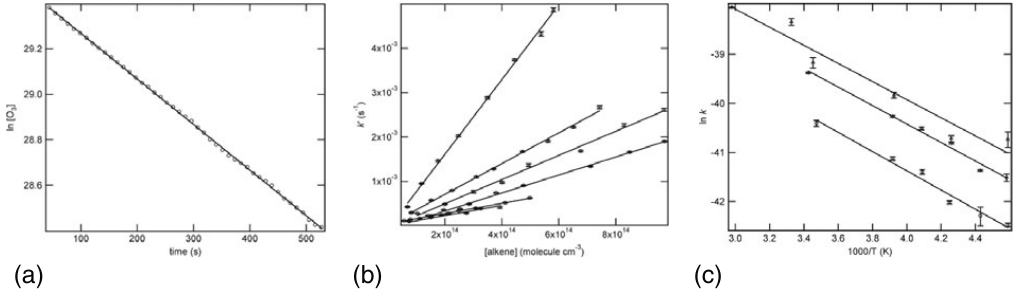
Fig. 8. (a) First order plot of ln[O ] vs time for the reaction of O 3 with 4-methyl-1-pentene. (b) Second plots 3 for 4-methyl-1-pentene from 218–292 K. (c) Arrhenius plots for (from top) 2,4,4-trimethyl-pentene, 4-methyl-1- pentene and